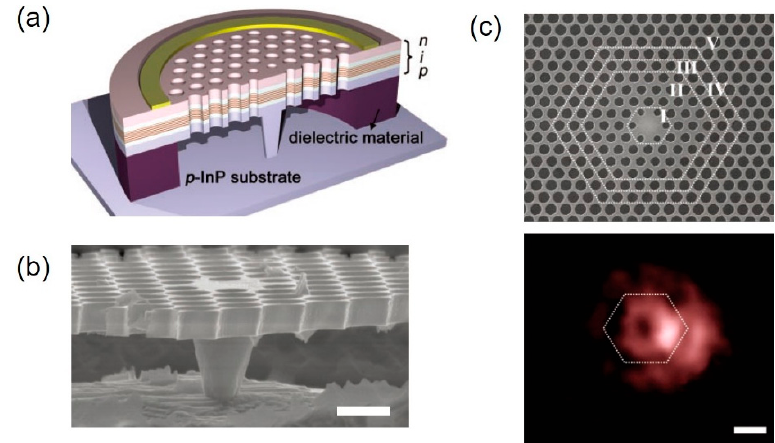
Figure 3. Electrically driven 2D photonic crystal (PhC) nanocavity lasers. ( a ) Schematic of the cross section of a PhC nanocavity. The vertically n - i - p -doped semiconductor wafer is supported by dielectric material. The entire PhC structure is air-suspended except for the central cavity region, which is connected to the p -type substrate through the central post. ( b ) Tilted SEM image of electrically driven 2D InGaAsP-PhC/InP-post nanocavity laser. ( c ) SEM image of sample showing different regions with different air-hole sizes (top) and Charge-coupled device (CCD) image of lasing mode (bottom) [22]. Figure reproduced with permission from American Association for the Advancement of Science.